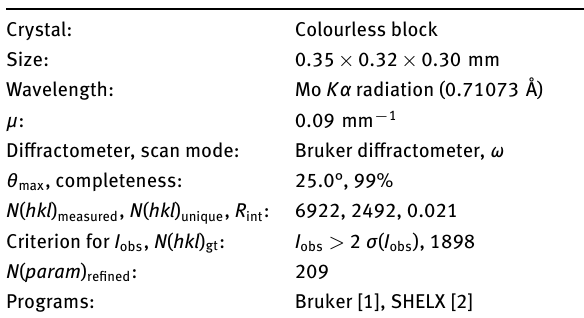
Table 1: Data collection and handling.